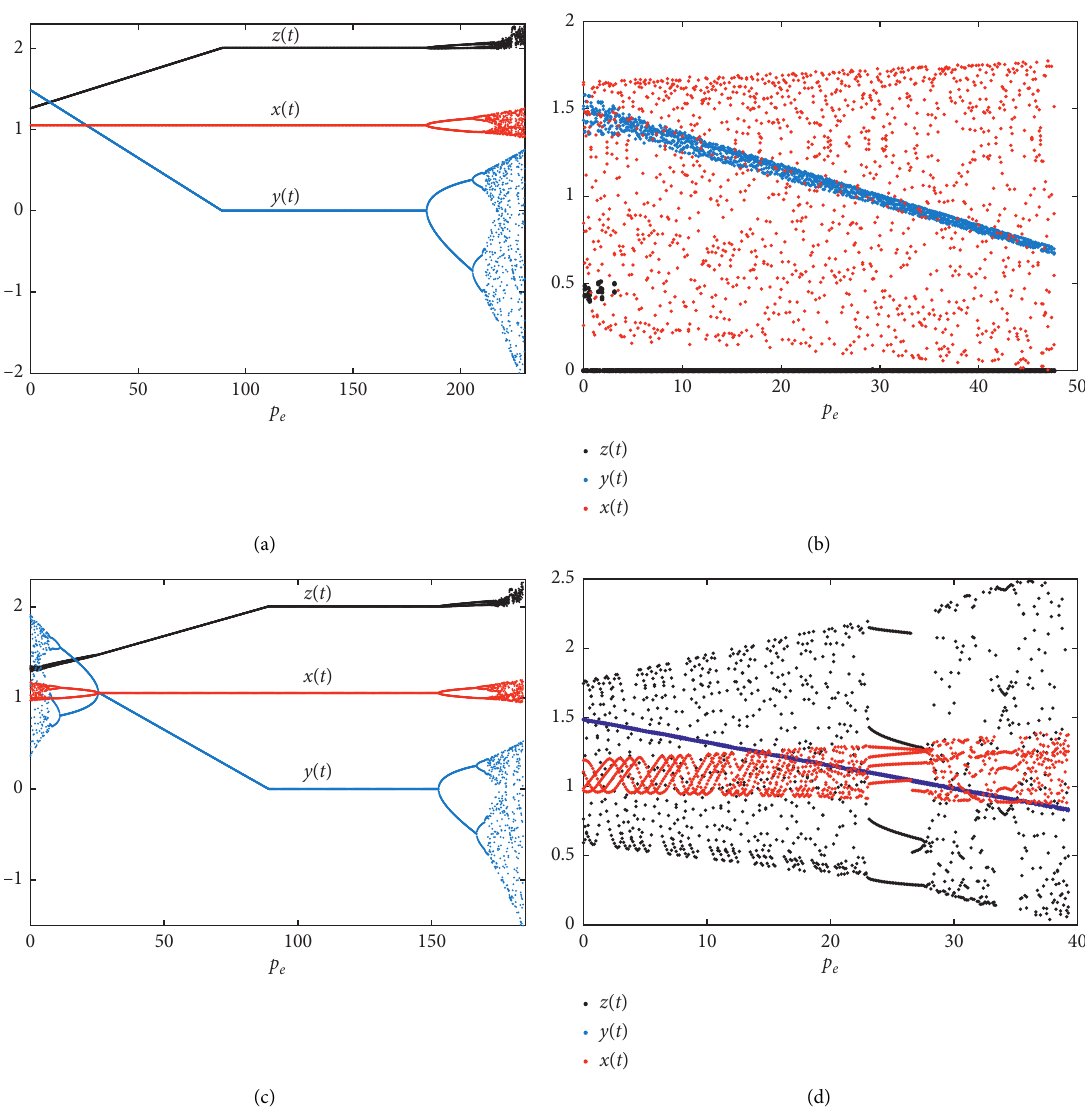
Figure 15: Bifurcation diagram with respect to p � 0 . 7 , α (c) α 1